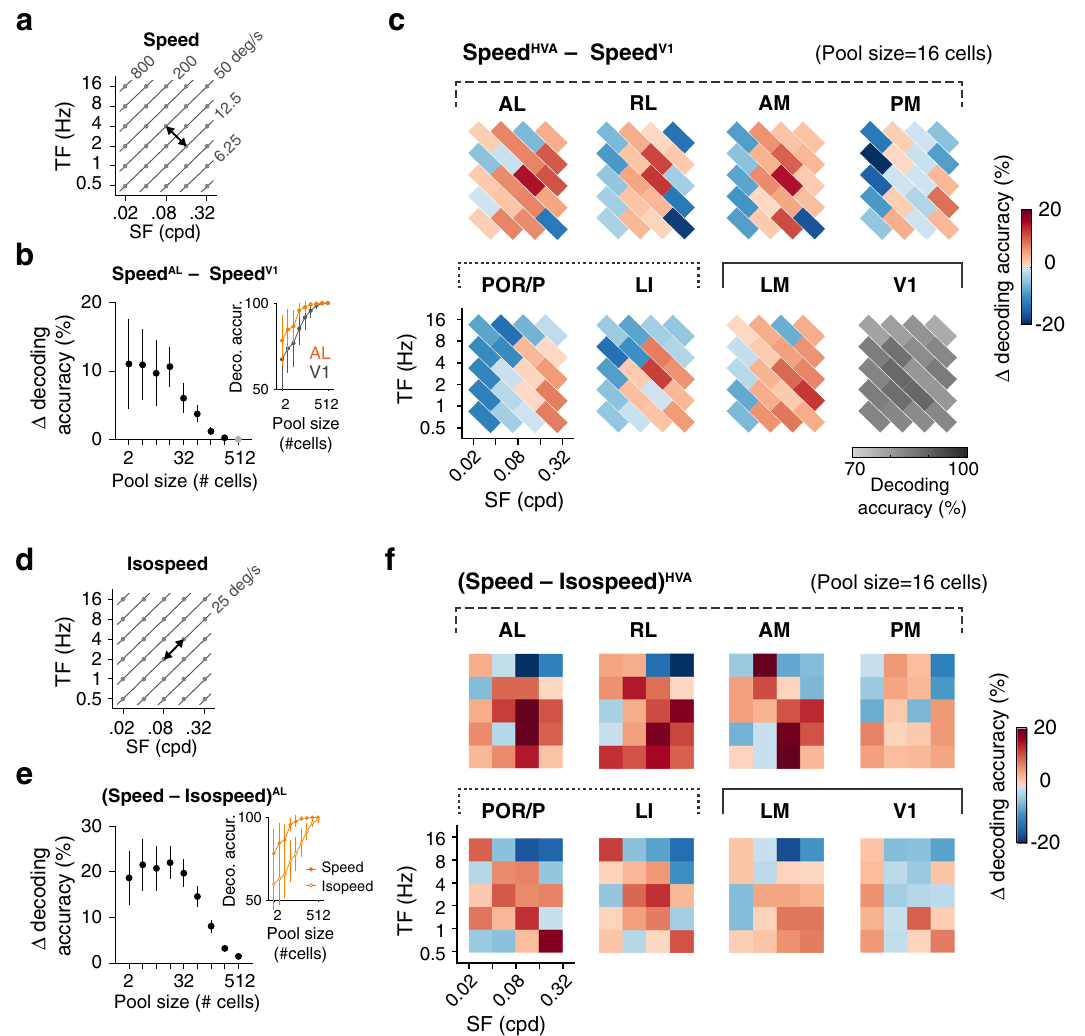
Fig. 4 Neural decoding reveals enhanced speed discrimination in higher visual areas. a Decoding neural responses to spatiotemporal stimuli of different speed (speed pairs). Speed pairs are sampled orthogonally to iso-speed lines and have a 4-fold difference in speed. b Fractional difference of decoding accuracy in area AL relative to V1, for the speed pair shown in a . The difference varies as a function of the size of the decoding neuron ensemble (pool size). The curve is calculated based on the speed decoding performance of AL and V1 data (inset, the chance level at 50% accuracy; n = 50 randomizations; mean ± 95% con fi dence intervals). Two-sample t-tests. Signi fi cant differences are shown as black markers, otherwise gray markers. c Summary of differences in speed decoding performance in higher visual areas relative to V1. V1 speed decoding performance is shown as a reference. See Supplementary Fig. 8b for statistical signi fi cances. Pool size: 16 cells. d Decoding neural responses to stimuli of different spatiotemporal frequencies but identical visual motion speed (iso-speed pairs). e Fractional difference of decoding accuracy observed when comparing results for the speed and iso-speed pairs shown in a and d , in area AL. Note the increased decoding performance for the speed pair relative to the iso-speed pair. Solid circle: speed pair. Open circle: iso-speed pair. Same style as b . f Summary of differences in decoding accuracy between speed pairs and corresponding iso-speed pairs in different areas. See Supplementary Fig. 8d for statistical signi fi cances. Pool size: 16 cells.